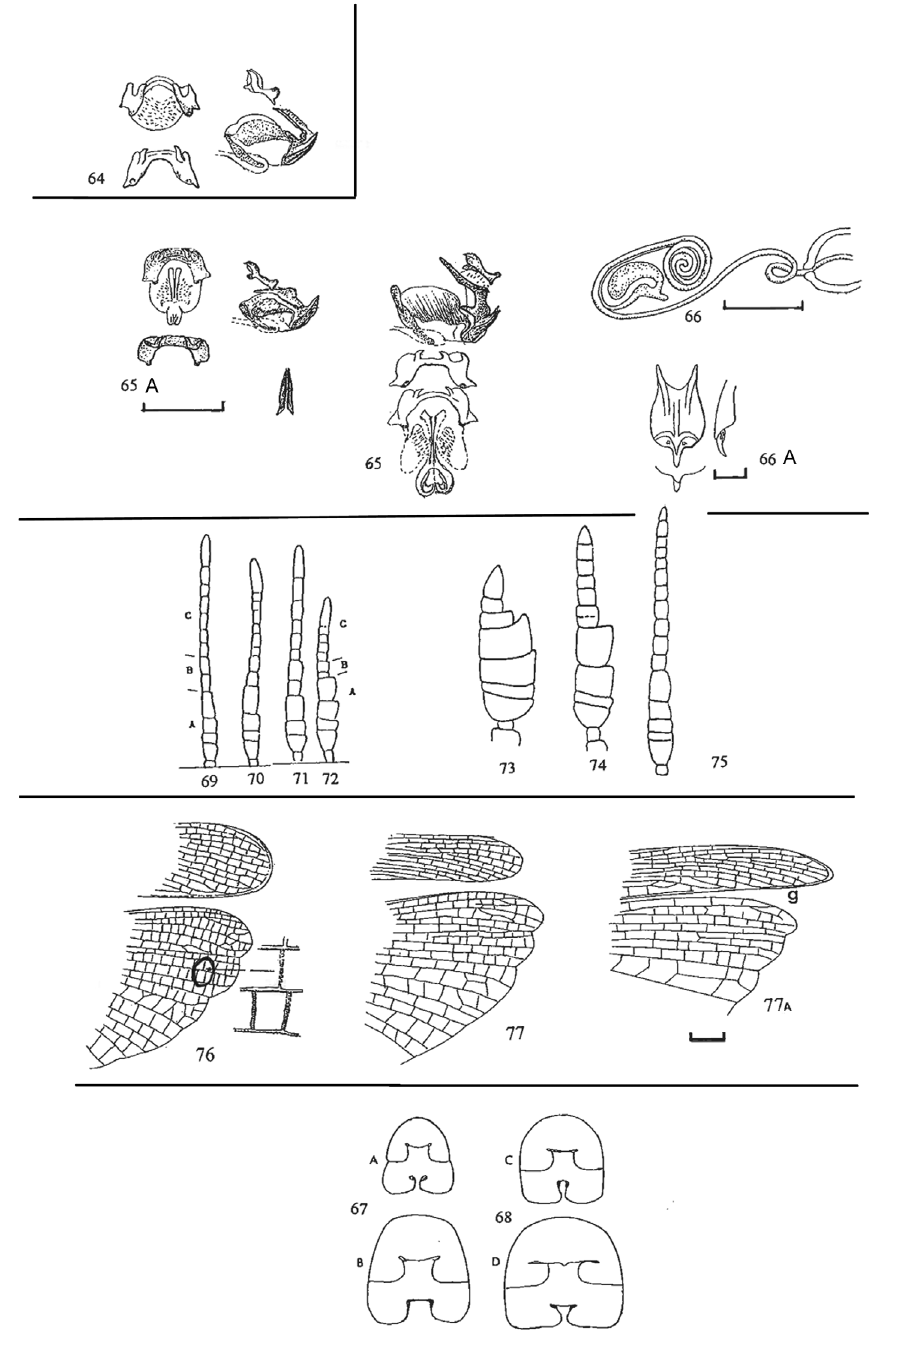
Figs 64–77. Morphology of the Ocnocerus genus group. Figs 64–66. Reproductive structures. 64, 65. Male phallic complex (lateral as- pect whole complex; epiphallus and ectophallic membrane; dorsal aspect epiphallus); 64. Rhabdoplea munda Karsch, 1893; 65. Sumba roseipennis I. Bolívar, 1912 ; 65A . S. exilis sp. n.; 66. S. roseipennis, female genitalic complex - ( 66. Spermathecal duct; 66A. Subgenital plate, entire from above, tip from ventral aspect and tip from lateral aspect, left side). Figs 67–68. Meso- and metasterna of: 67A. Acte- ana alazonica Karsch, 1896 male, and 68B . Same, female; 68C . Anacteana neavei neavei I. Bolívar, 1912 male; 68D . Same, female. (Note: Acteana is not a member of this genus group, it is a member of the Pargaini, but very similar to Anacteana. See Figs 331–340). Figs 69–75 . Antennal morphology. Figs 69–72. Variation in antennae of Anacteana n. neavei . 69. Male Tanzania, Ufipa; 70. Female same locality; 71. Male Zambia, Mweru wa Ntipa; 72. Female, same locality. Figs 73–75. Antennal morphology, other genera. 73. Hyperoc- nocerus sulculatus; 74. Ocnocerus diabolicus ; 75. Panzia uvarovi. Figs 76, 77, 77A. Fore and hind-wing apices. 76. Panzia uvarovi (including enlarged section showing thickened cross-veins); 77. Sumba callosa ; 77A. Sumba exilis n. sp. , showing longer and more pointed tegmen. All scale lines represent l mm: that under Fig. 66 applies to Figs 64, 65 and 65A; that under Fig. 66A applies uniquely to it; that under Fig. 77A applies to Figs